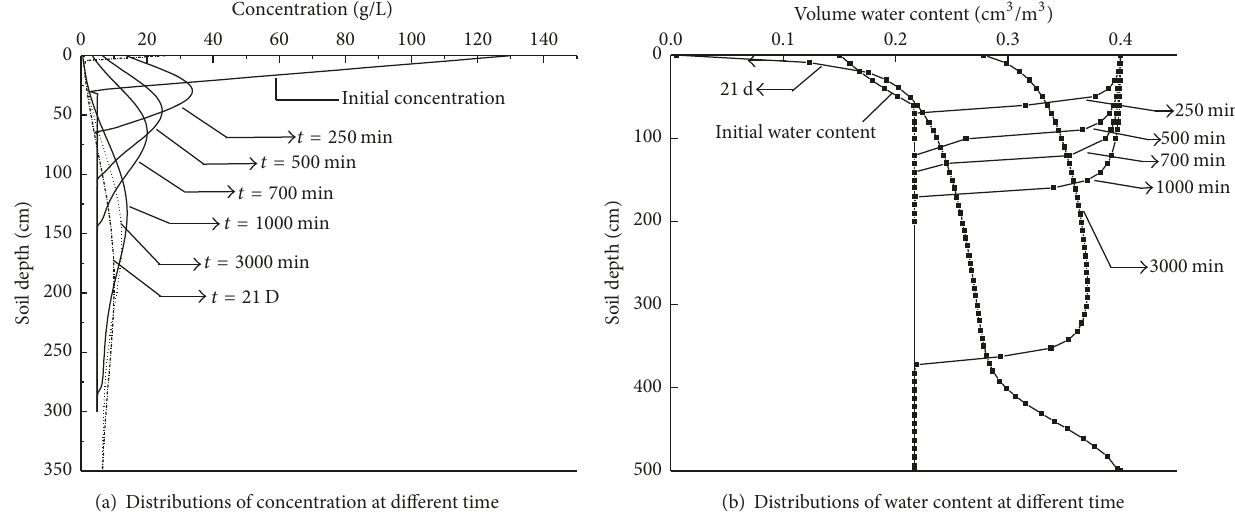
Figure 2: Numerically simulated results of salt leaching and